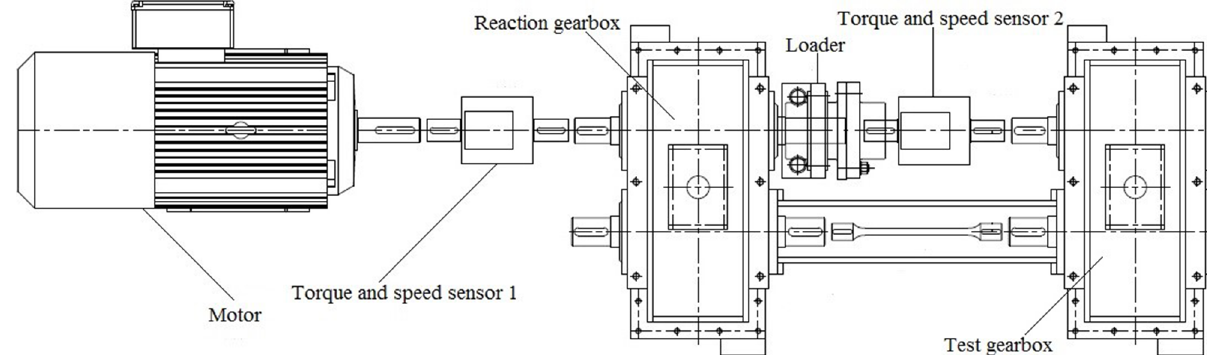
Fig. 10. The schematic diagram of test-rig for transmission ef fi ciency of double helical gears with closed power fl ow.